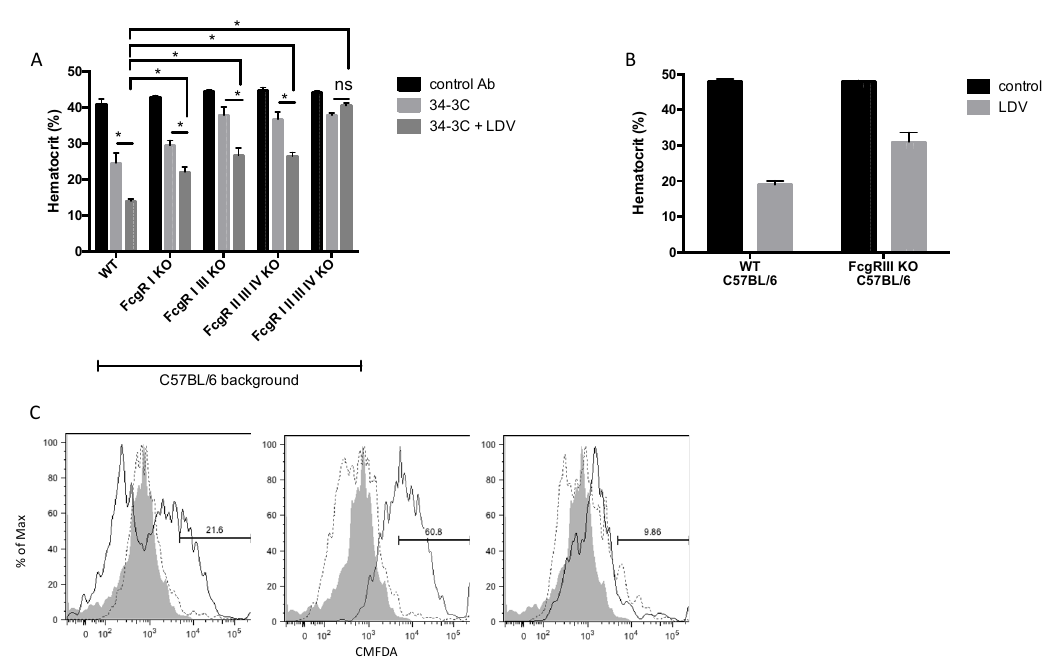
Figure 2. Involvement of Fc γ receptors in LDV-exacerbated in vivo and ex vivo erythrophagocytosis. ( A , B ) Hematocrits of C57BL/6, Fc γ R I KO, Fc γ R I/III KO, Fc γ R II/III/IV KO, Fc γ R I/II/III/IV KO ( A ), and Fc γ R III KO ( B ) mice, 4 days after administration of 50 µ g of 34-3C mAb. LDV infection was performed one day before the antibody challenge. The results are representative of at least 2 experiments and shown as the means ± SEM, ). * p < 0.05. ( C ) Ex vivo erythrophagocytosis of non-opsonized (dashed line) or 34-3C-opsonized (plain line) CMFDA-stained RBCs by macrophages isolated from (left panel) mock-infected C57BL/6, (middle panel) LDV-infected C57BL/6, and (right panel) LDV-infected Fc γ R I/II/III/IV KO (grey: fluorescence of macrophages without RBC incubation). The results are representative of at least 2 independent experiments.